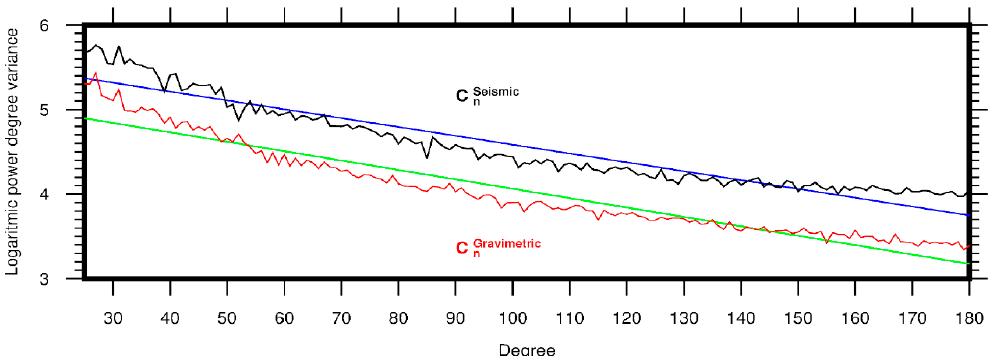
Figure 1. The logarithmic power–degree variances of the CRUST1.0 (black line), VMM (red line), and fitted regression lines between degrees 25 and 180. Blue and green lines are the fitted lines to the CRUST1 and VMM models, respectively. “Seismic” and “gravimetric” denote the CRUST1.0 and VMM models, respectively.